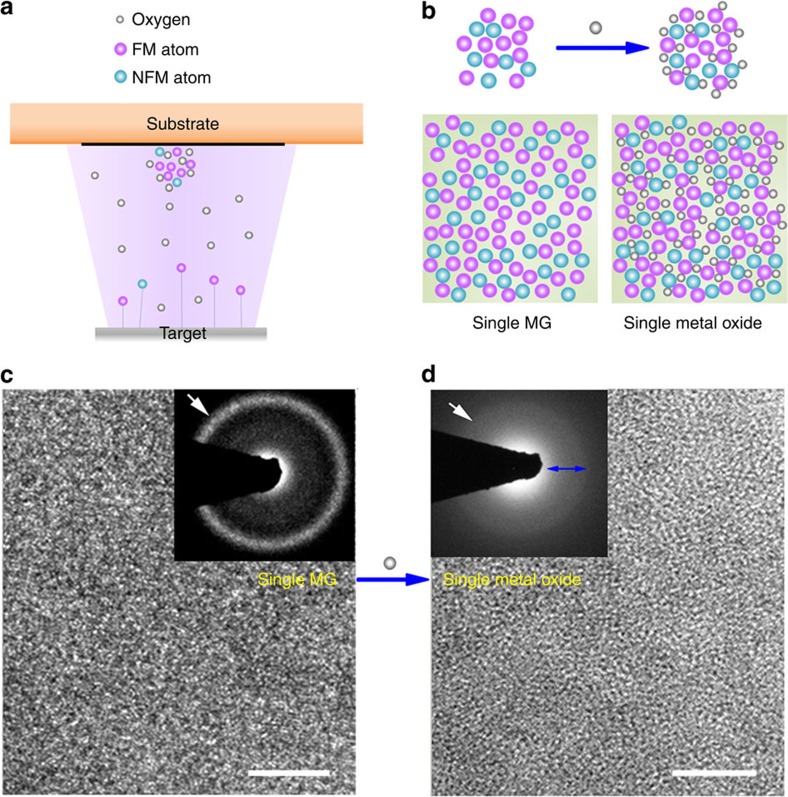
Formation of an amorphous metal oxide from a ferromagnetic metallic glass.(a) Schematic diagram illustrating deposition of thin films. (b) Oxidation mechanism of the ferromagnetic (FM)–non-ferromagnetic (NFM) system. (c,d) High-resolution transmission electron microscopy images of the single-phase Co44Fe20Ta10B26 MG ribbon and the single-phase Co28.6Fe12.4Ta4.3B8.7O46 amorphous metal oxide. The insets are the corresponding selected-area electron diffraction patterns of the MG ribbon and the amorphous metal oxide, respectively. Scale bars, 5 nm.